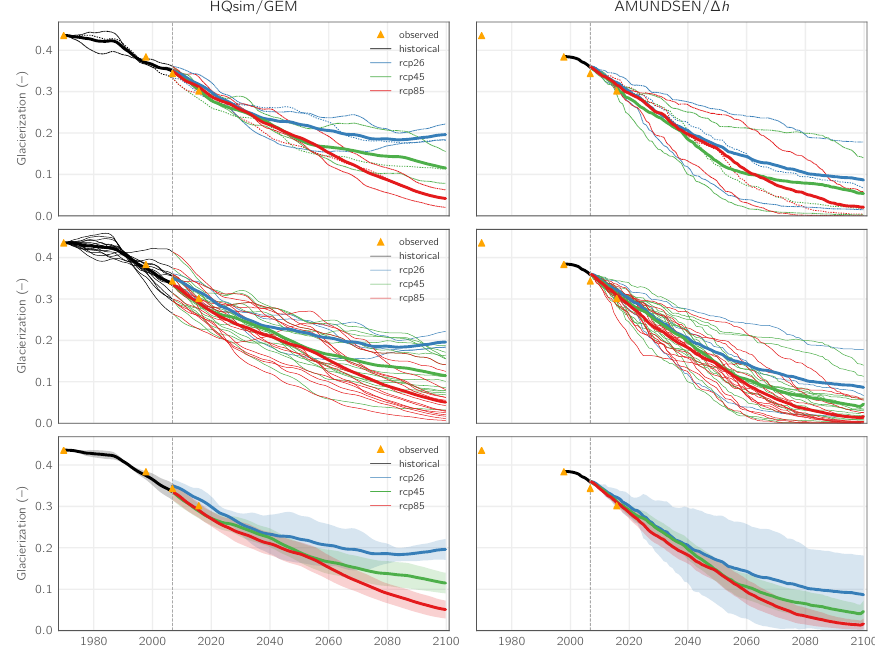
Figure 4. Results for the catchment glacierization from the two glacio-hydrological models HQsim-GEM ( left sub-figures) and AMUNDSEN ( right sub-figures). The top row shows only the three GCM-RCM combinations which are available for all three RCPs, the middle row all GCM-RCM combinations (i.e., three for RCP 2.6 and 14 each for RCP 4.5 and 8.5), and the bottom row the same but with the uncertainty (95% confidence interval) shown as shaded bands instead of the individual model